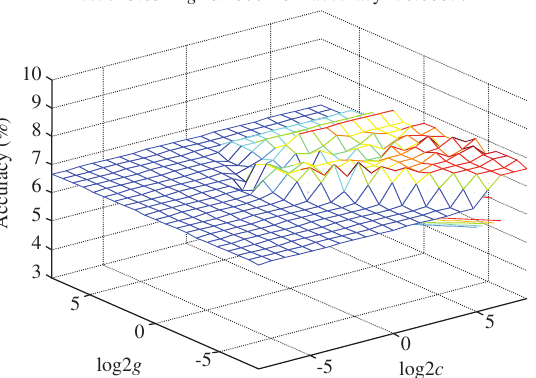
Figure 4: Three-Dimensional (3D) Figure of the Optimized Results of the Second Group of